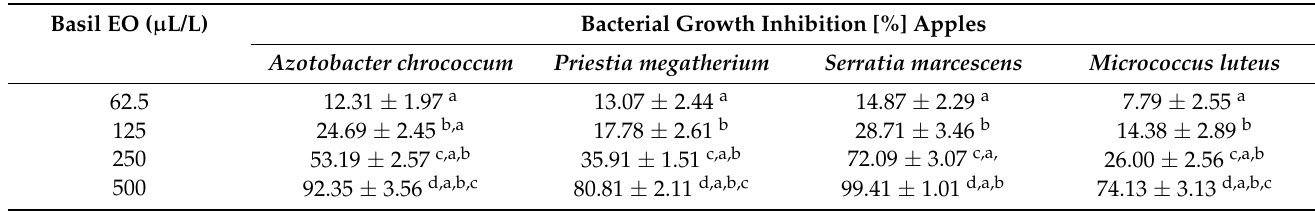
Means ± standard deviation ( n = 3). Individual letters (a–d) in upper case indicate the statistical difference at p ≤ 0.05. Table 5. In situ analysis of the anti-yeast activity of the vapor phase of OBEO on apples.